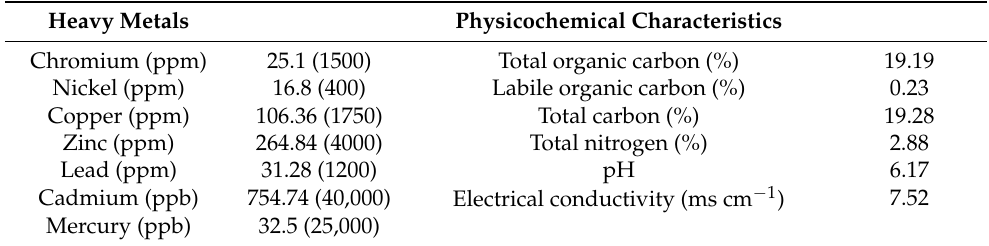
Table 1. Heavy metal content and physicochemical characteristics of the composted sewage sludge. The number in brackets indicates limit values (ppm) of heavy metals for application in agricultural soils with pH > 7, according to the RD 1390/1990 Spanish